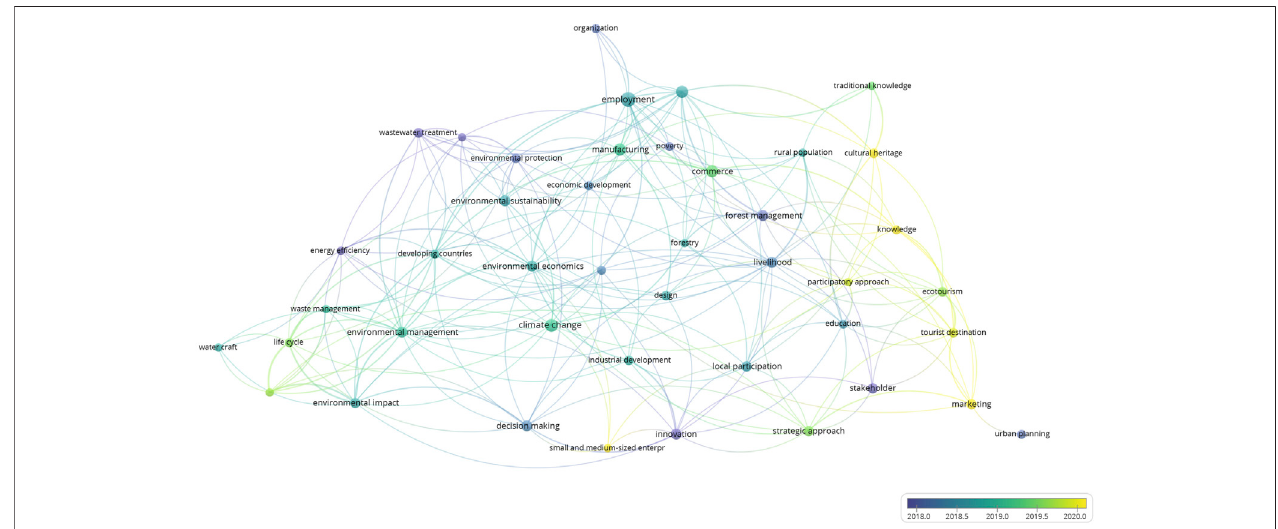
FIGURE 9 | Future research trends in sustainable crafts. Source: Authors ’